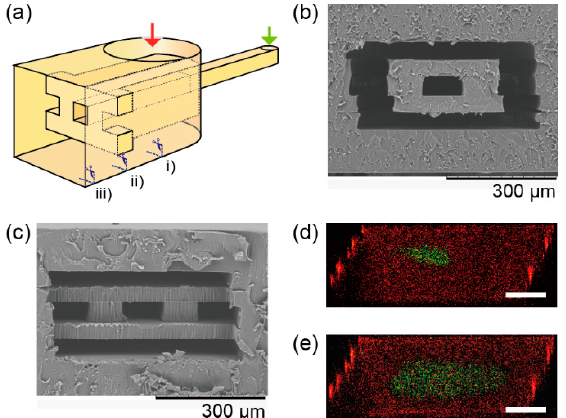
Figure 6. Cross-sectional images of a 3D sheath device. ( a ) Conceptual image of the 3D sheath device. ( b ) A SEM image of a cross section of the device at position (i) in Figure 6a, and ( c ) at position (ii) in Figure 6c. ( d ) A confocal microscope image of the 3D sheath at position (iii) with the flow rate of fluorescein as 90 µL/min and rhodamine as 450 µL/min. ( e ) Fluorescein as 40 µL/min and rhodamine as 210 µL/min. Scale bars are 100 µm.